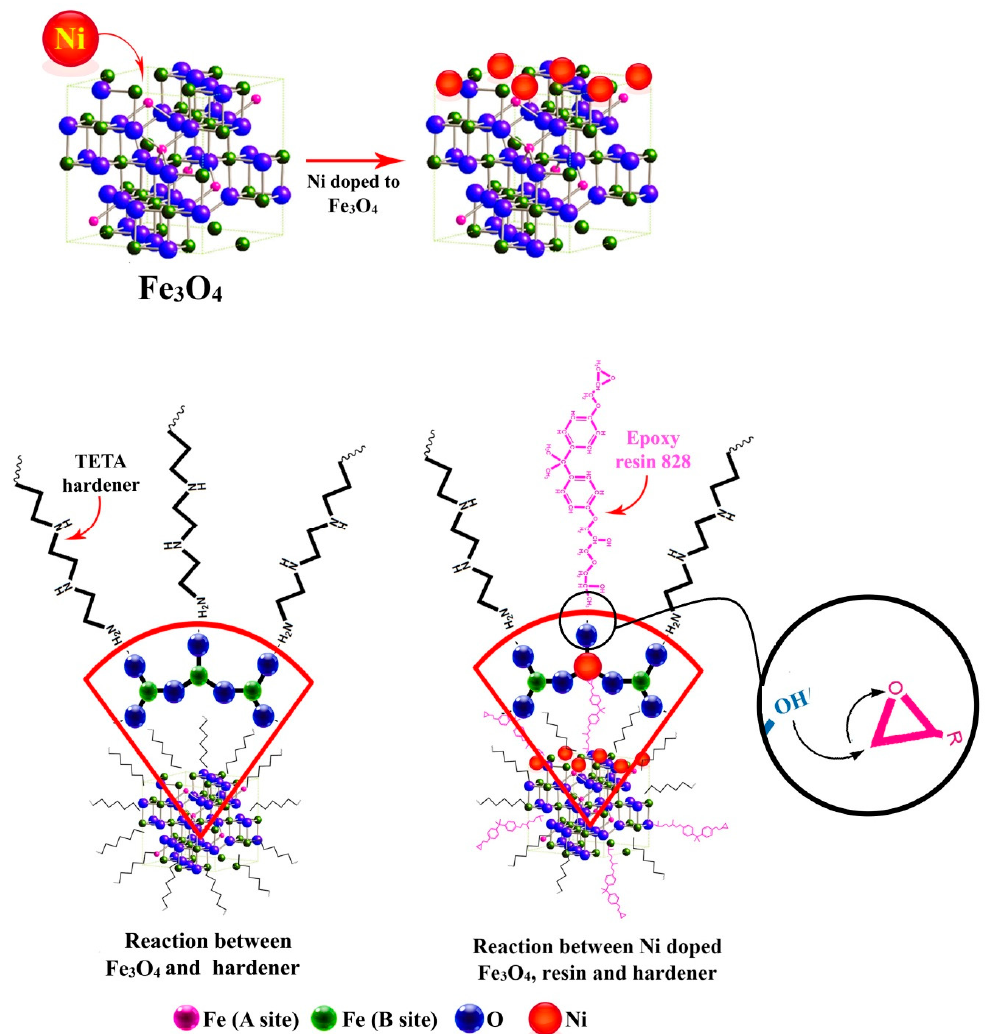
Figure 6. The possible reaction of Fe 3 O 4 and Ni-Fe 3 O 4 with the epoxy resin and the curing agent. Table 2. The values of α p , α m and α p ∞ obtained from the Malek model at various heating rates.